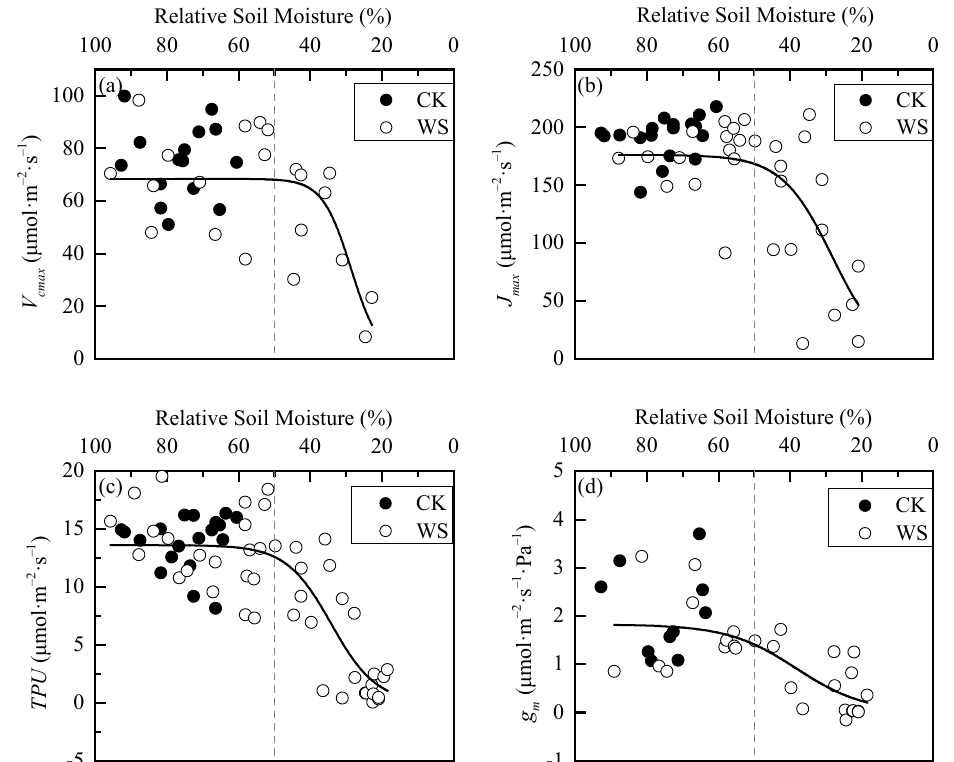
Figure 6. Dynamics in photosynthetic biochemical parameters of spring wheat leaves under different relative soil moisture: ( a ) V cmax parameter, ( b ) J max parameter, ( c ) TPU parameter, and ( d ) g m parameter. CK refers to the control group. WS refers to the continuous drought group. The grey dashed line is the reference line of 50% relative soil moisture. Table 5. One-way ANOVA of photosynthetic biochemical parameters of spring wheat leaves under different soil water treatments. CK: the control group; WS: the continuous drought group. Parameter